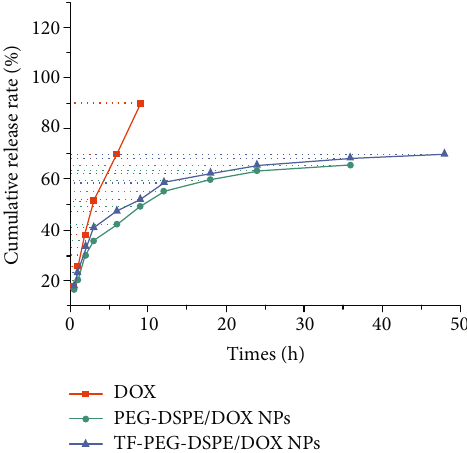
Figure 6: The cumulative in vitro release of the